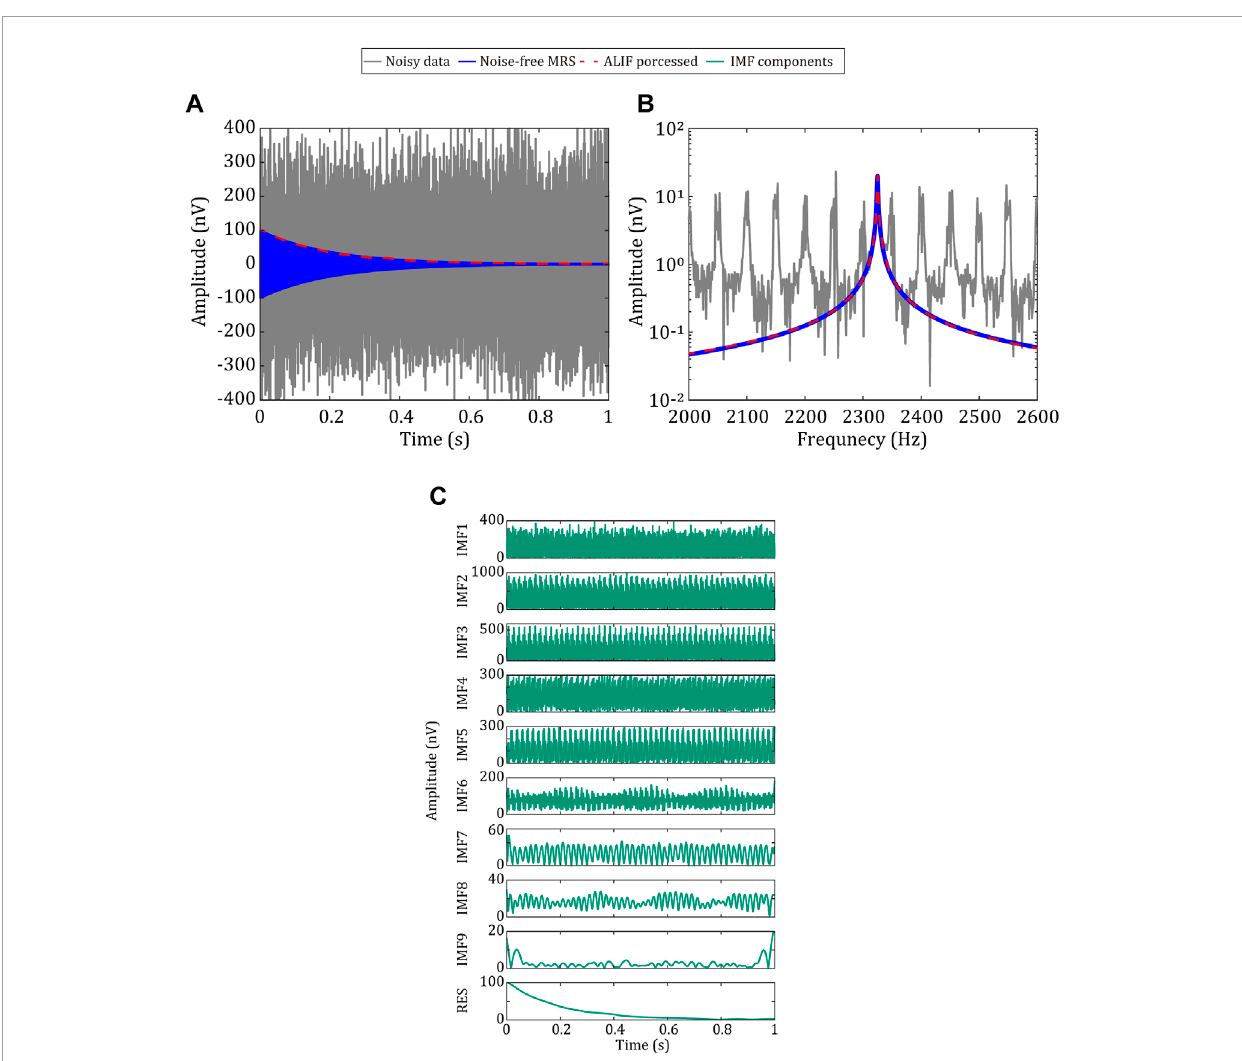
FIGURE 1 Results of MRS signal processing with the ALIF algorithm; (A) and (B) are the time domain diagram and frequency domain diagram, respectively, of the noisy MRS data (gray), noise-free MRS signal (blue), and signal envelope extraction by the ALIF algorithm (red); (C) from top to bottom, nine IMF components and residual signals decomposed by the ALIF